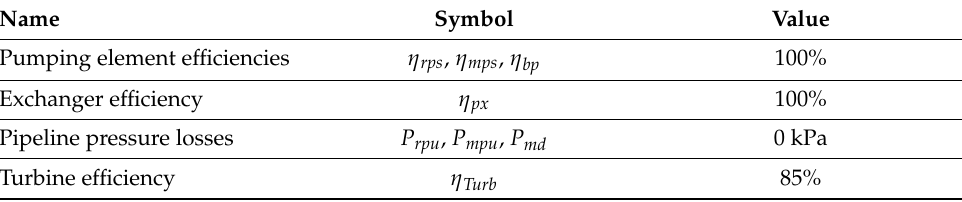
Table A6. Hydraulic system specifications and efficiency of the turbine of the PRO unit.